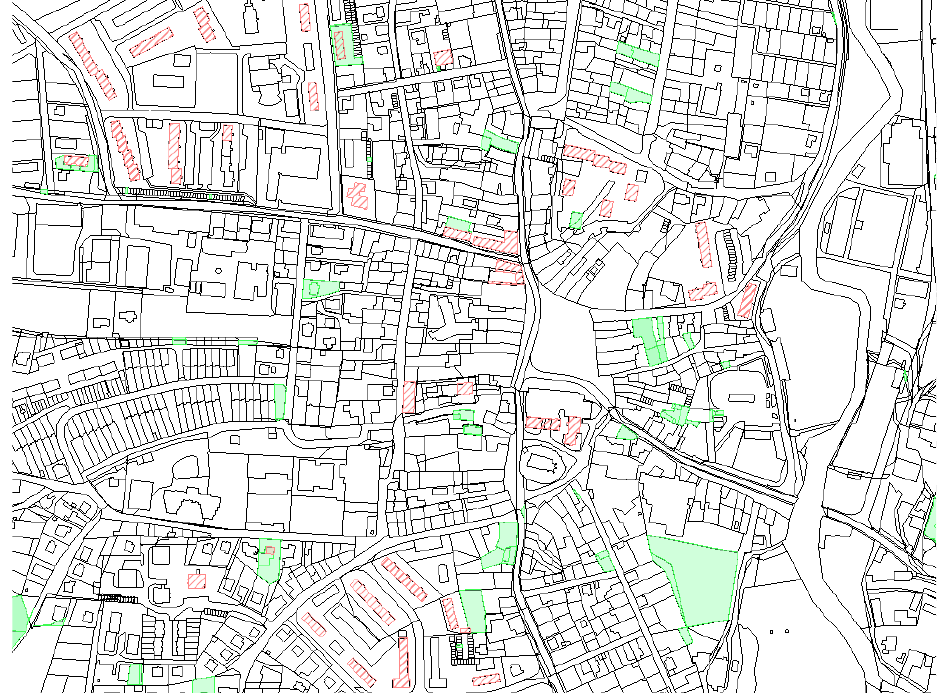
Figure 5: Cadastral map with marked properties with listed price data (source: authors with use of [10]) There are no housing units in cooperative or similar ownership among the offer advertisements.